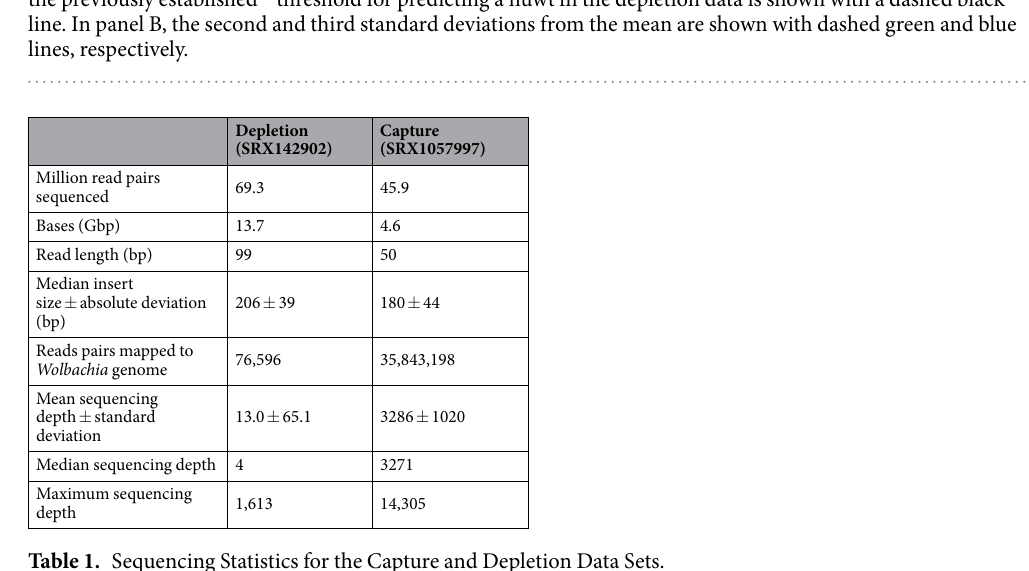
data: (1) the copy number of the nuwt, (2) the relative abundance of Wolbachia chromosomes compared to the nematode chromosomes, and (3) the presence of suitable oligonucleotides in the capture pool. Factors 1 and 2 are interdependent. For example, if there are four Wolbachia genome equivalents for every nematode genome equiva- lent in the sample, then it may only be possible to predict nuwts that have at least four copies per nuclear genome, resulting in a 2-fold increase in sequencing depth for diploid organisms. However, the third factor is independent as it relates to how the oligonucleotide capture pool was designed. In this case, the major concern is the known removal from the capture pool of baits corresponding to reference nematode sequences, which included some nuwts. The exclusion of nuwts will lead to gaps in the tiling of the Wolbachia genome, although these missing regions may be partially or completely captured by probes to adjacent sequences in a fragment. With regards to all three of these factors, we expect this depletion data set to better predict nuwts than this capture data set. However, as discussed in the Background, Wo lbachia- depletion is not always feasible. Previously 17 , we described the limits of applying statistical tests and models to predict nuwts given that the sequencing depth distribution of the depletion data was not bell-shaped and did not have a unimodal distribution (Fig. 3A, Table 1). In that study, for detection of nuwts, we were able to justify an empirically derived threshold of 16x sequencing depth through visual comparison of the sequencing depth distributions of the B. malayi sequenc- ing data and the Wolbachia data 17 . With the oligonucleotide capture system presented here, sequencing data from the B. malayi genome lacking homology to Wolbachia sequence is not available for such an analysis. However, the sequencing depth distribution of the capture data appears to have a bell-shaped distribution (Fig. 3B) with similar values for the mean and median suggesting it is unimodal, or nearly unimodal (Table 1). This is most likely the result of the increased sequencing depth across the entire Wolbachia genome and the smaller relative